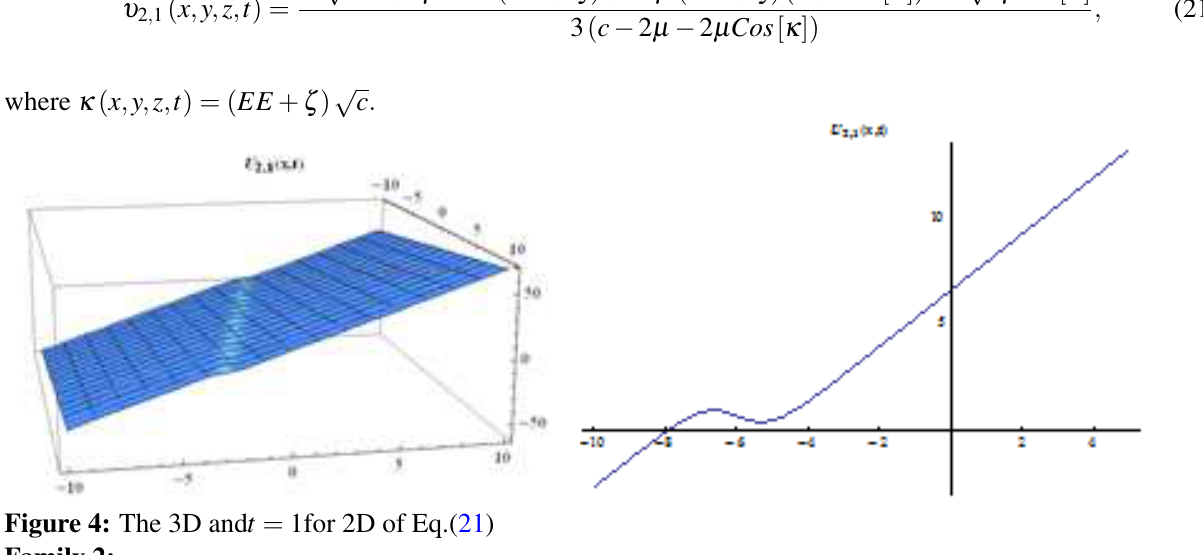
Figure 4: The 3D and t = 1for 2D of Eq.(21)